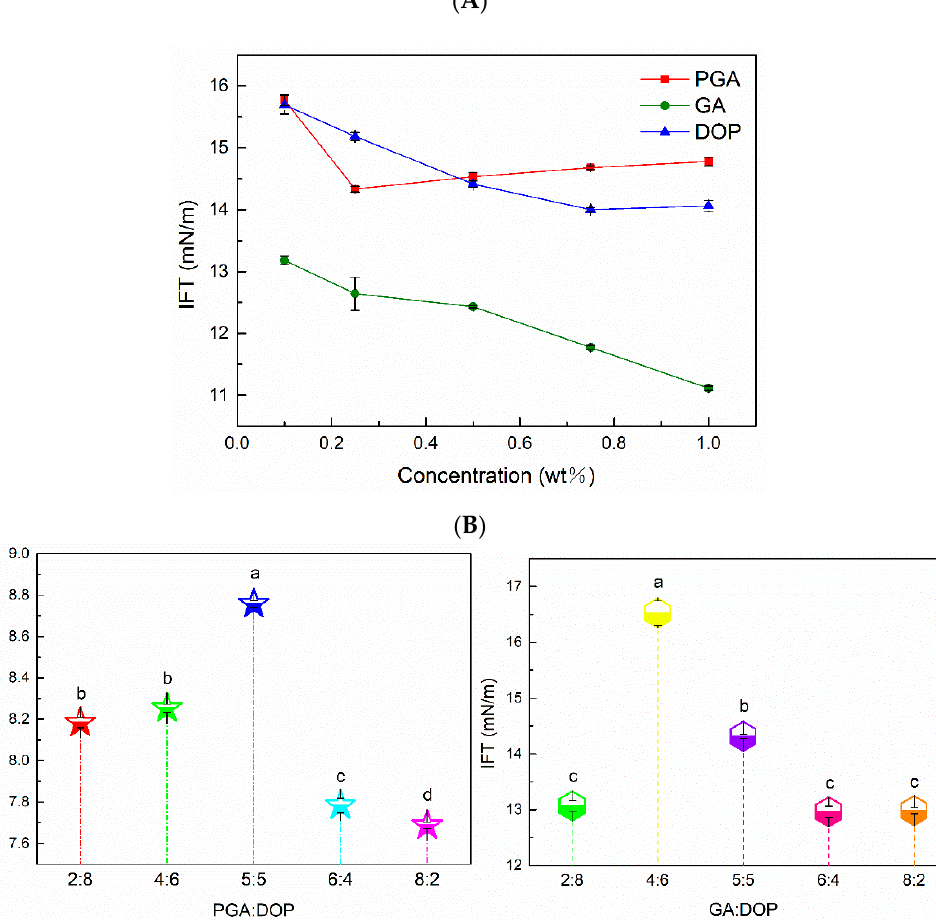
Figure 2. ( A ) Relationship between the interfacial tension (IFT) and concentration of three polysaccharides. ( B ) Interfacial tension (IFT) of the compound polysaccharides at different ratios (total concentration was 1 wt%), a–d indicate significant differences ( p < 0.01).